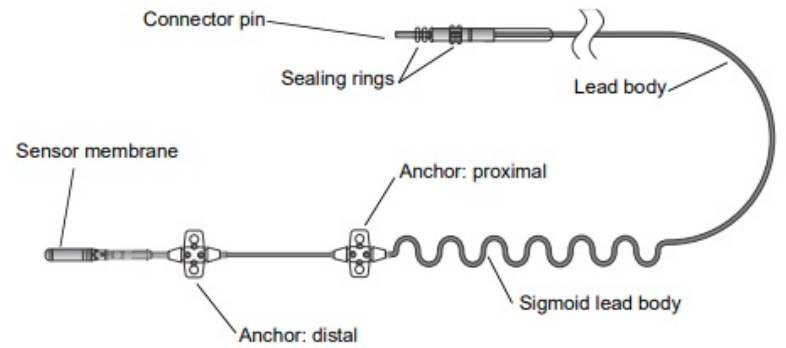
Figure 5. The Inspire respiratory sensing lead.